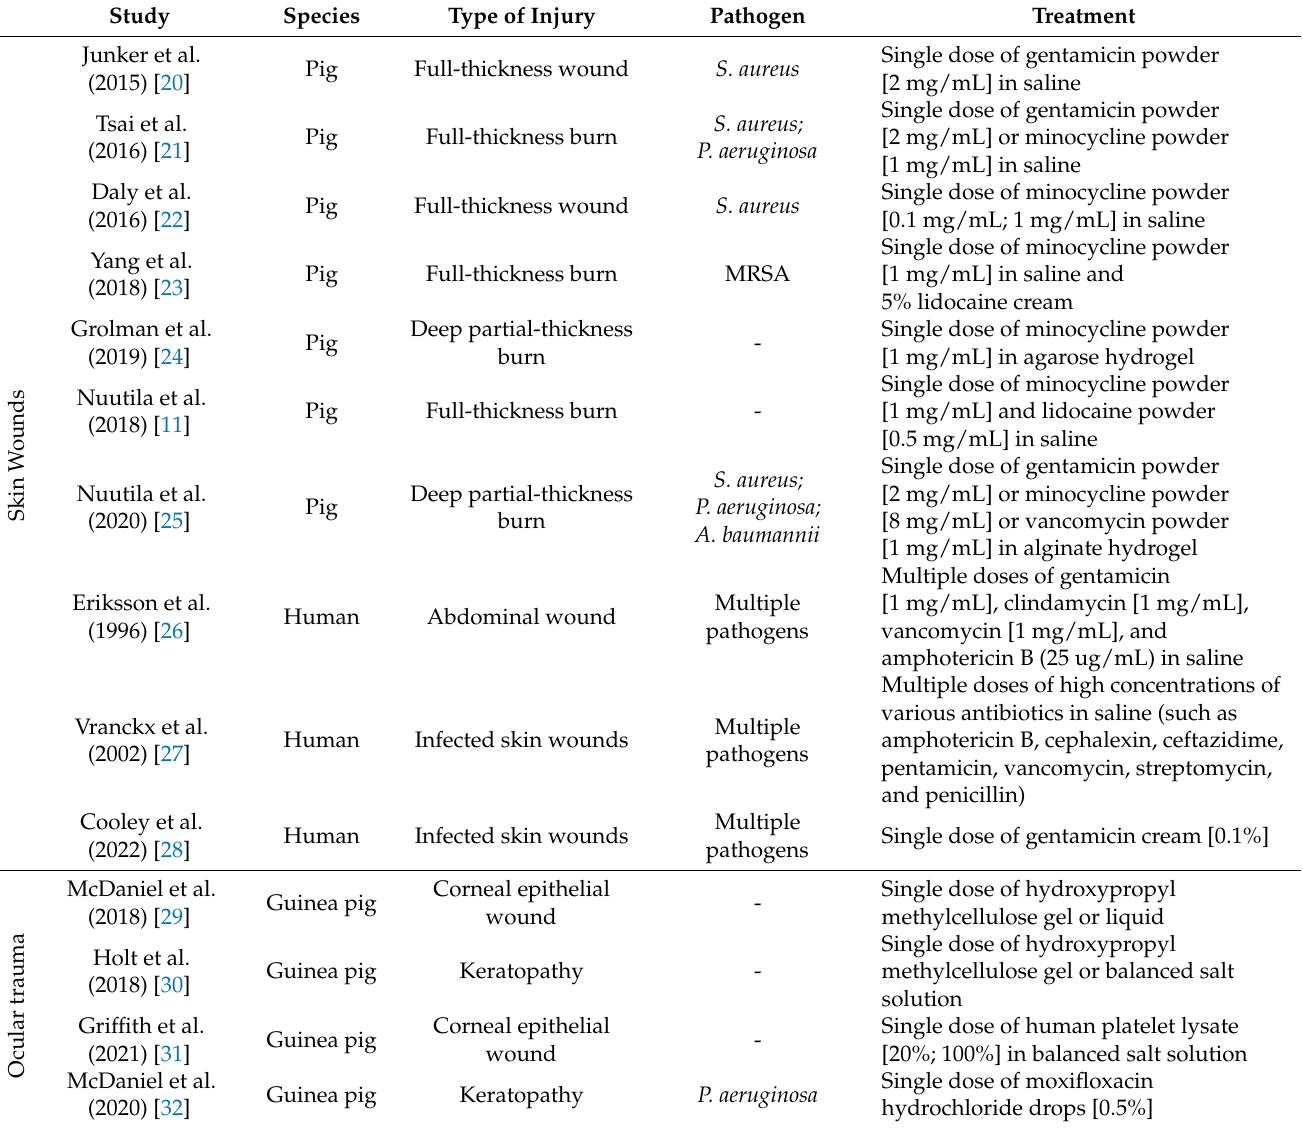
Table 1. Summary of the skin wound and ocular injury studies that have utilized the PWD in topical